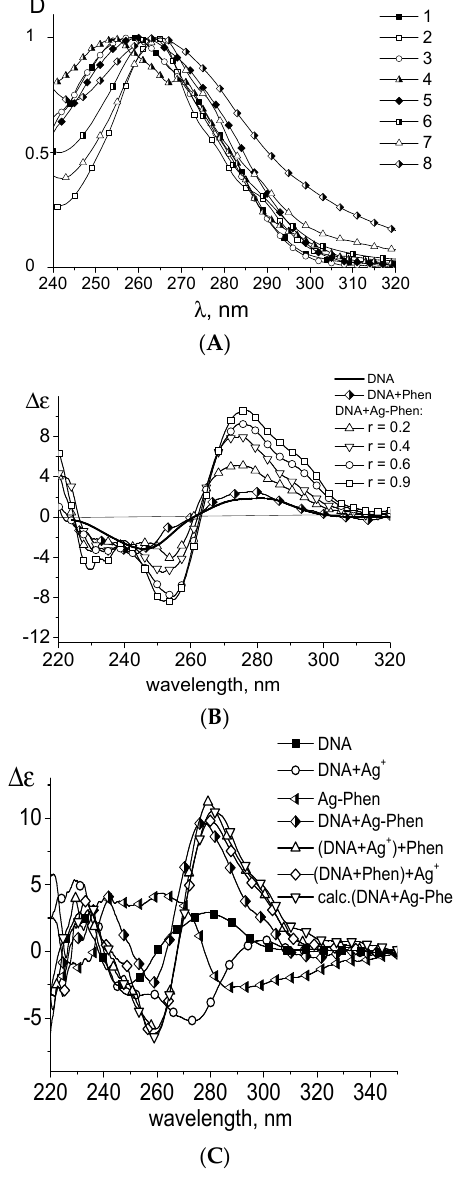
Figure 3. Normalized absorption spectra ( A ) of: DNA (1); Phen (2); Ag + (5); Ag–Phen (7); Phen in AgNO 3 solution (6); DNA in complexes with Phen (3); DNA in complexes with Ag–Phen (4); and DNA in a solution with Phen and AgNO 3 (8). CD spectra ( B , C ) of DNA in 5 mM NaNO 3 in complexes with Ag–Phen at different: r ( B ); and CD spectra ( C ) of DNA in complexes with Ag + , Ag–Phen, and Phen. The results of an addition of AgNO 3 to DNA+Phen solution [(DNA+Phen)+Ag + ] and an addition of Phen to DNA+Ag + solution [(DNA+Ag + )+Phen] and the result of subtracting of free Ag–Phen spectrum from the spectrum of DNA in complexes with Ag–Phen [calc.(DNA+Ag–Phen)] are shown. C (DNA) = 0.0025%, the solvent—5 mM NaNO 3 .